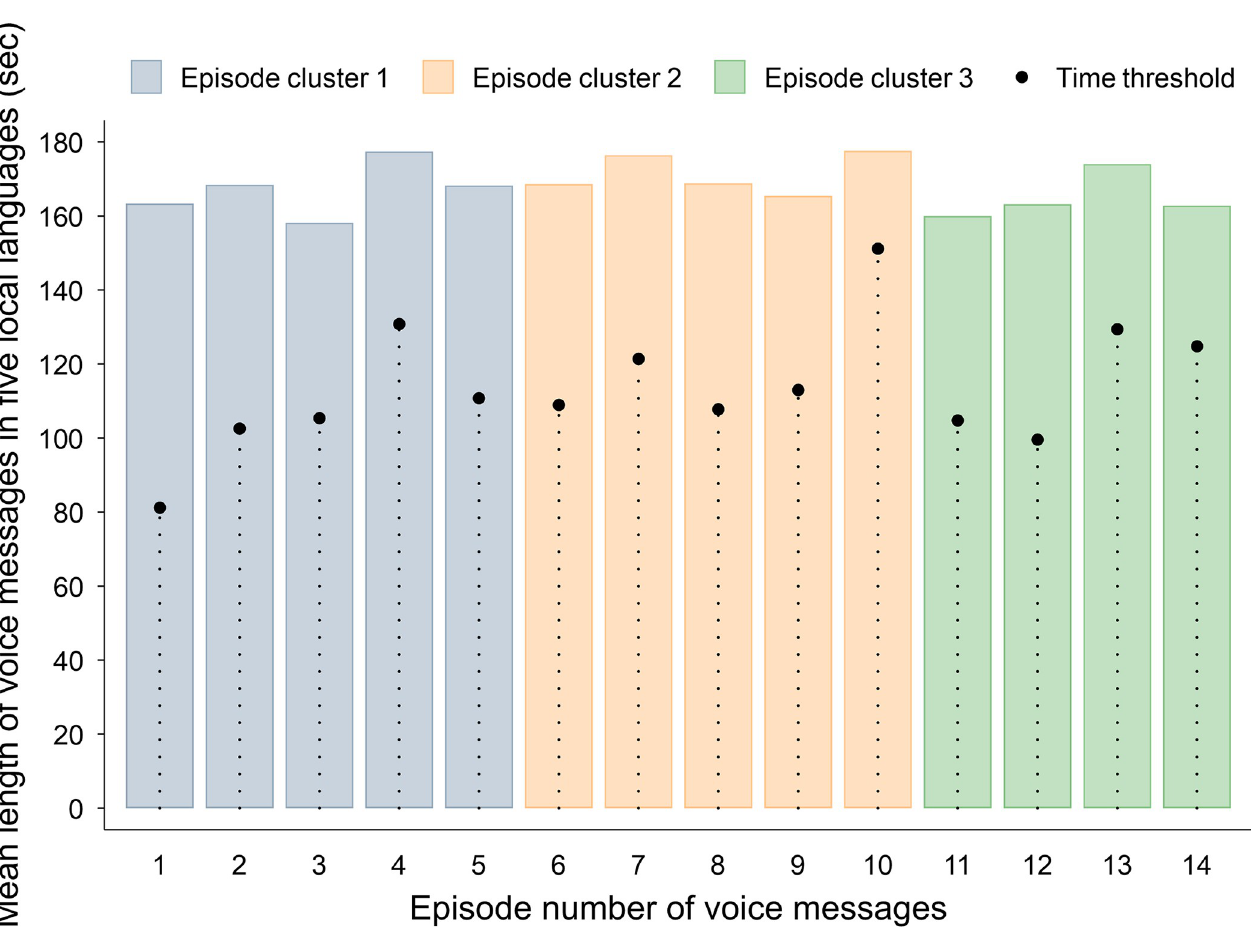
PLOS ONE | https://doi.org/10.1371/journal.pone.0275855 November7,